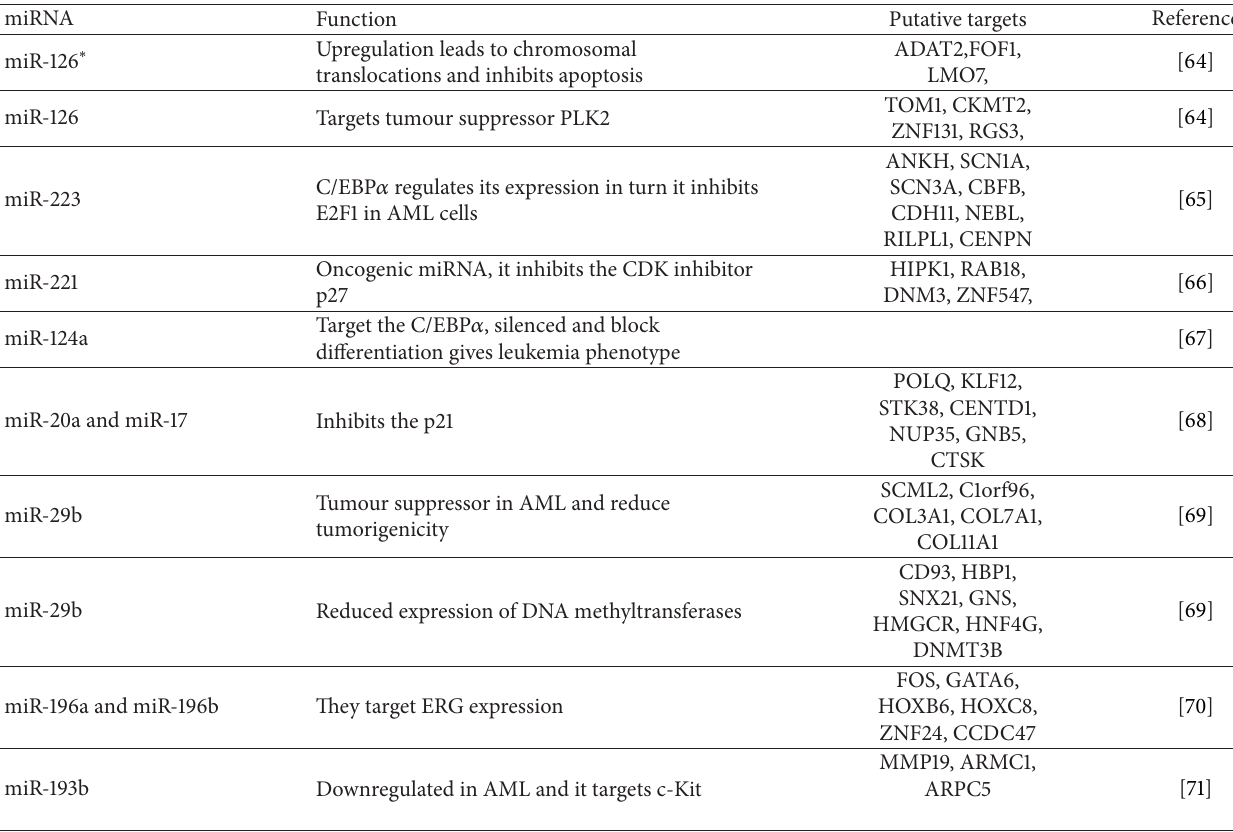
Table 6: miRNAs involved in